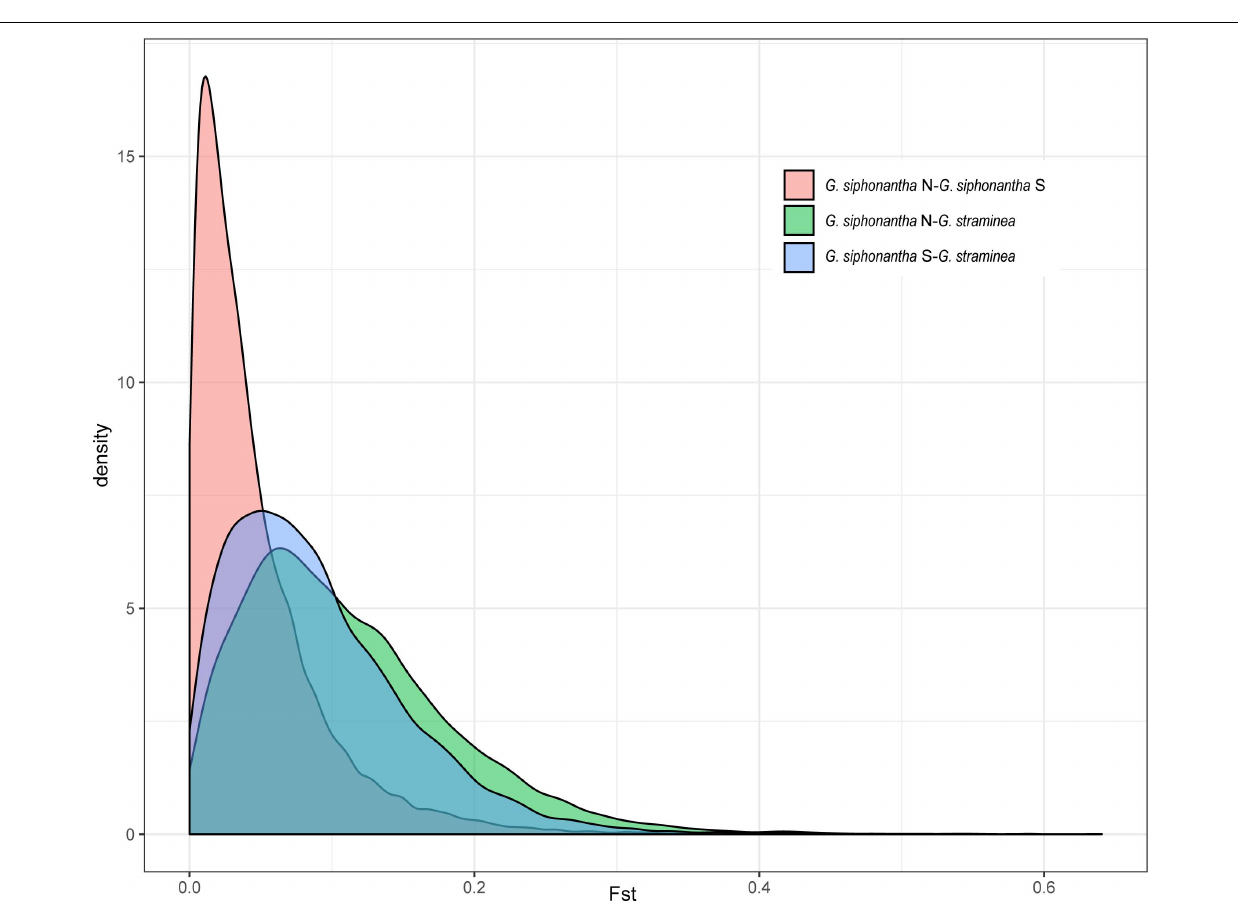
Frontiers in Ecology and Evolution |